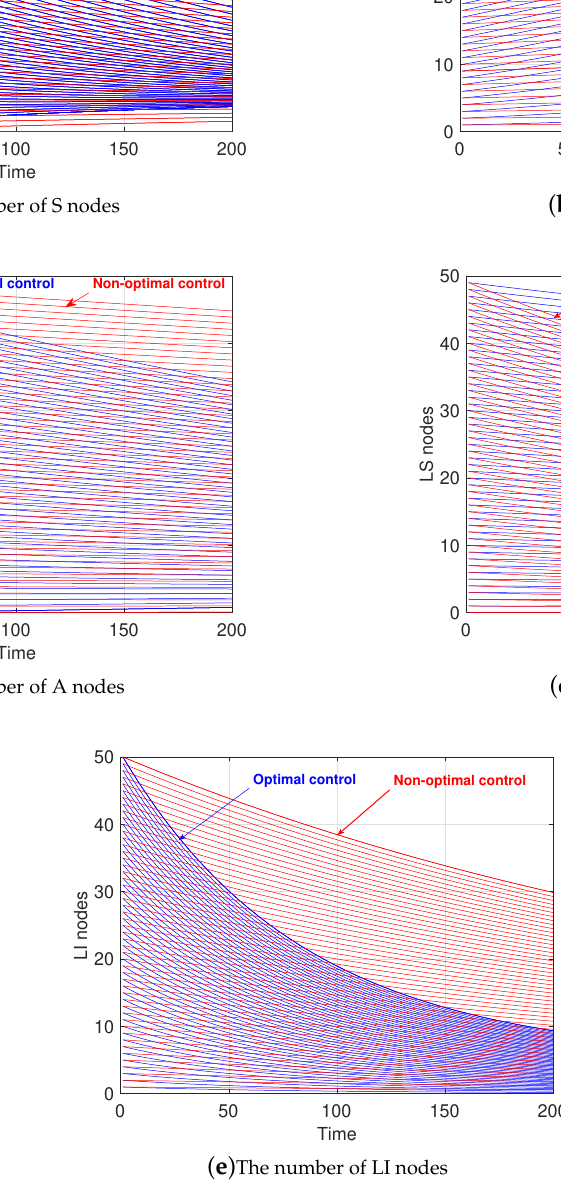
Figure 8. Evolution of state variables under various controls in the case of R 0 >